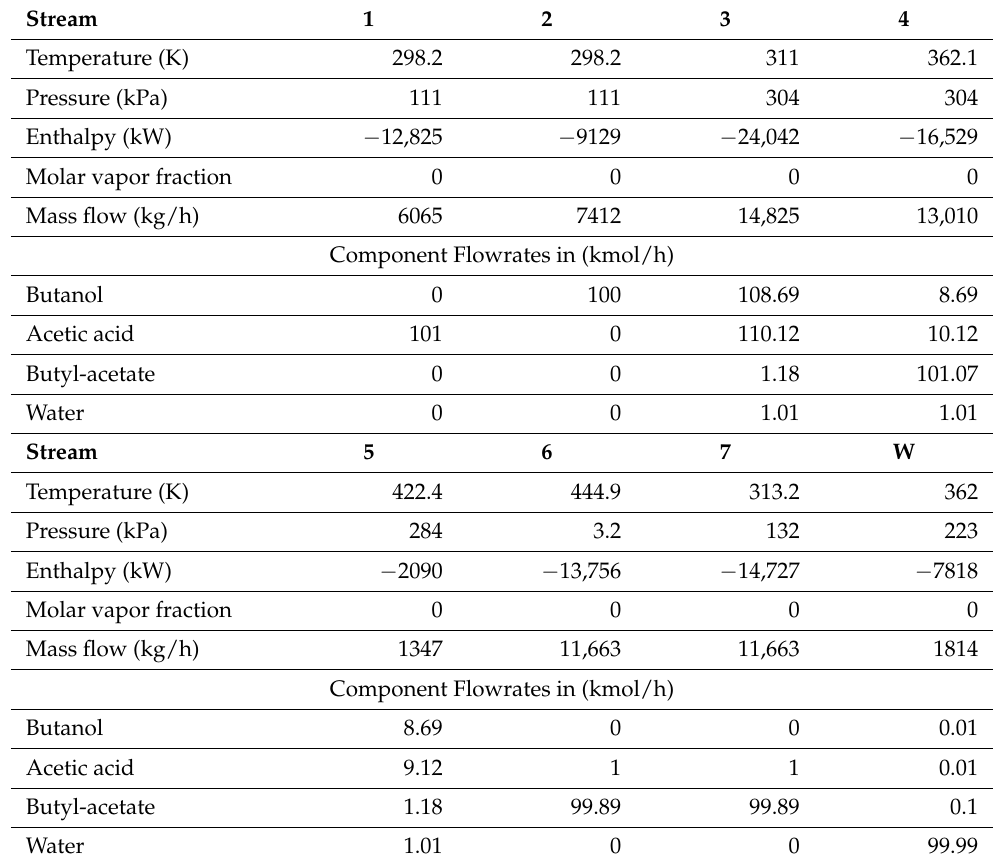
Figure 10. Liquid-phase molar compositions of components inside the extractive distillation column as a function of stage number. Table 4. Stream information of the MR-based process for n -butanol esterification with acetic acid.